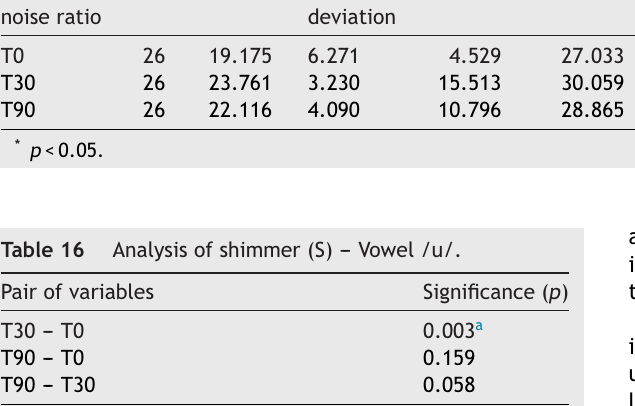
Harmonic---noise ratio --- Vowel /u/. Harmonic---